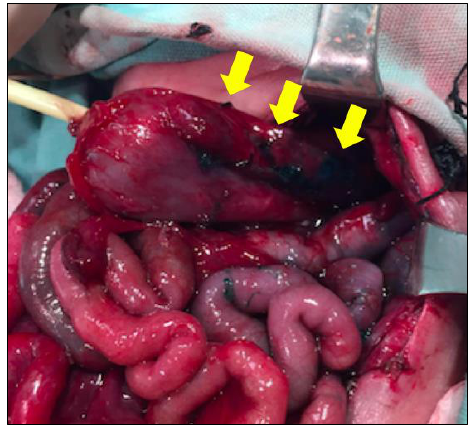
Figure 1: Multiple gastric perforations shown with arrows. The patient remained stable and tolerated nasogas- tric feeding until follow-up on the 15th postoperative day. Histopathology from the gastric resection re- ported hemorrhagic necrosis and a nonspecific acute inflammatory process without anatomic